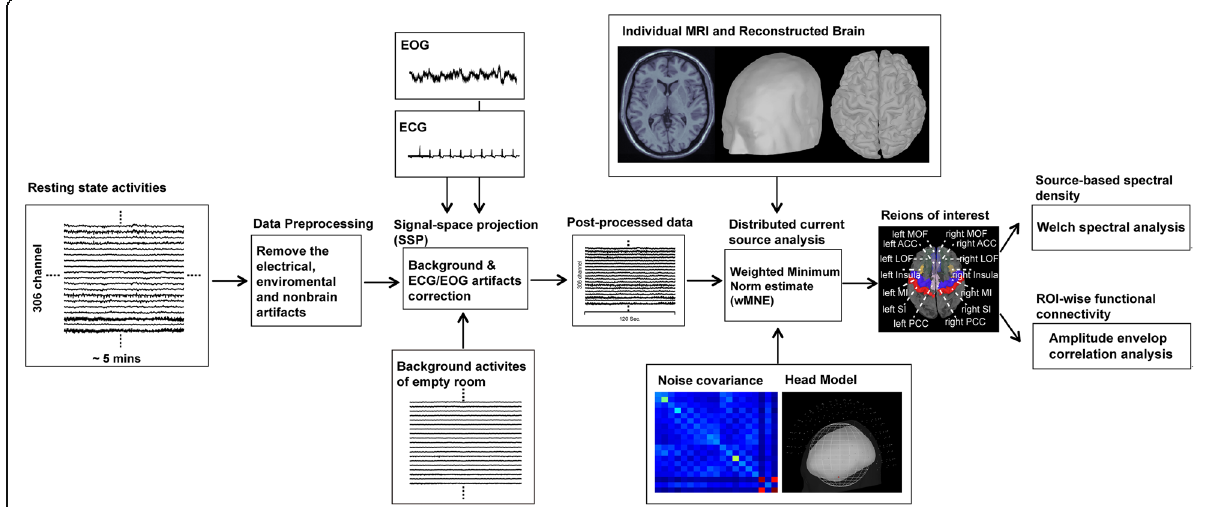
Fig. 1 Pipeline of source-based resting-state magnetoencephalographic spectral and functional connectivity